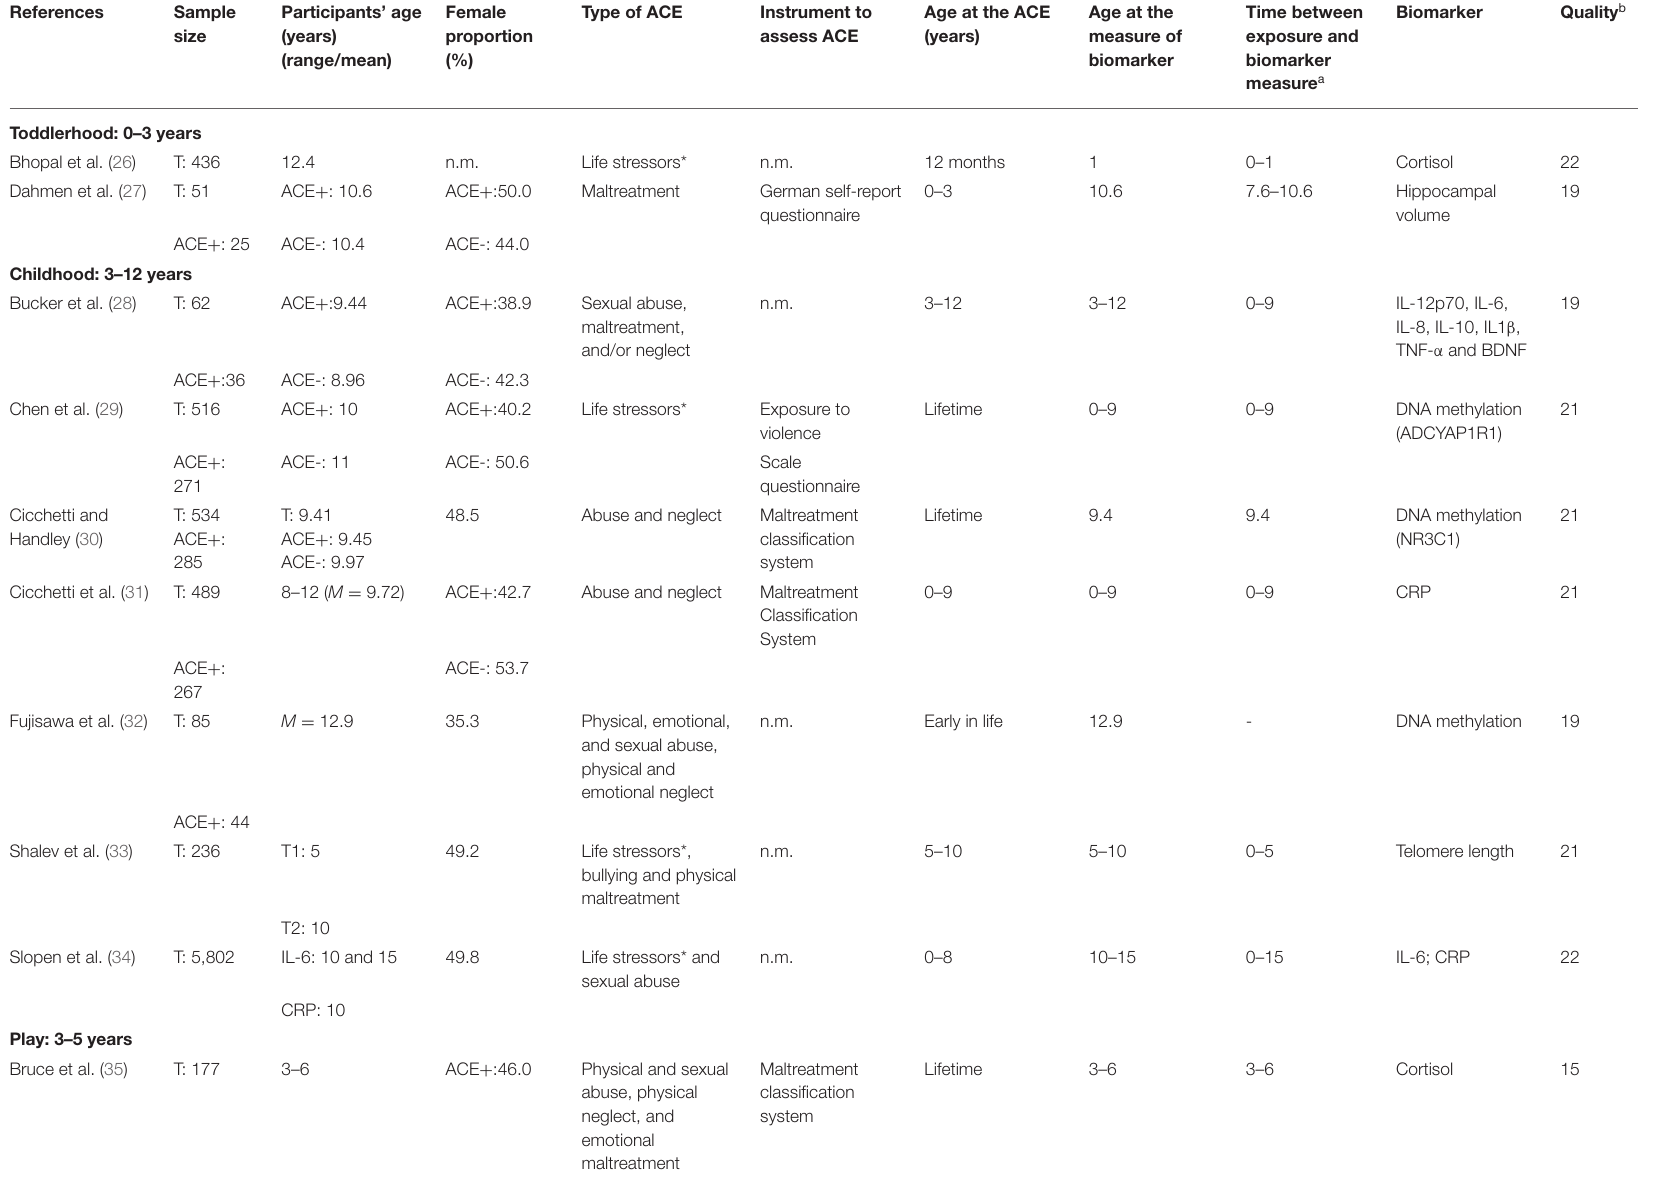
TABLE 2 | Descriptive characteristics of all included studies ( n =